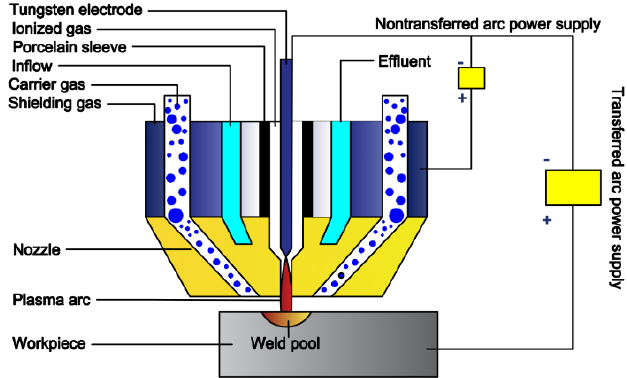
Figure 2. Schematic diagram of powder plasma surfacing equipment.